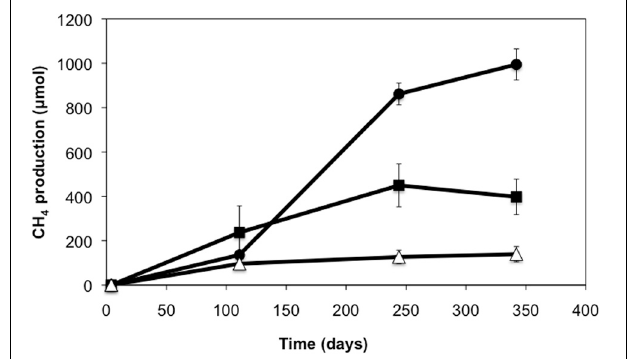
FIGURE 1 | Methane production in production water-derived incubations amended with light (circles) and heavy crude oil (squares) relative to oil-free controls (triangles). Error bars represent a standard deviation of the mean of triplicate incubations.